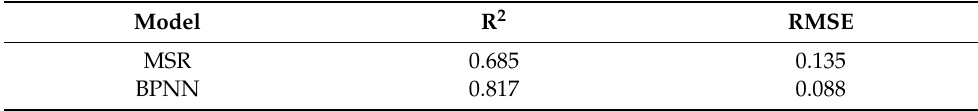
Table 15. A comparison of modeling accuracy.